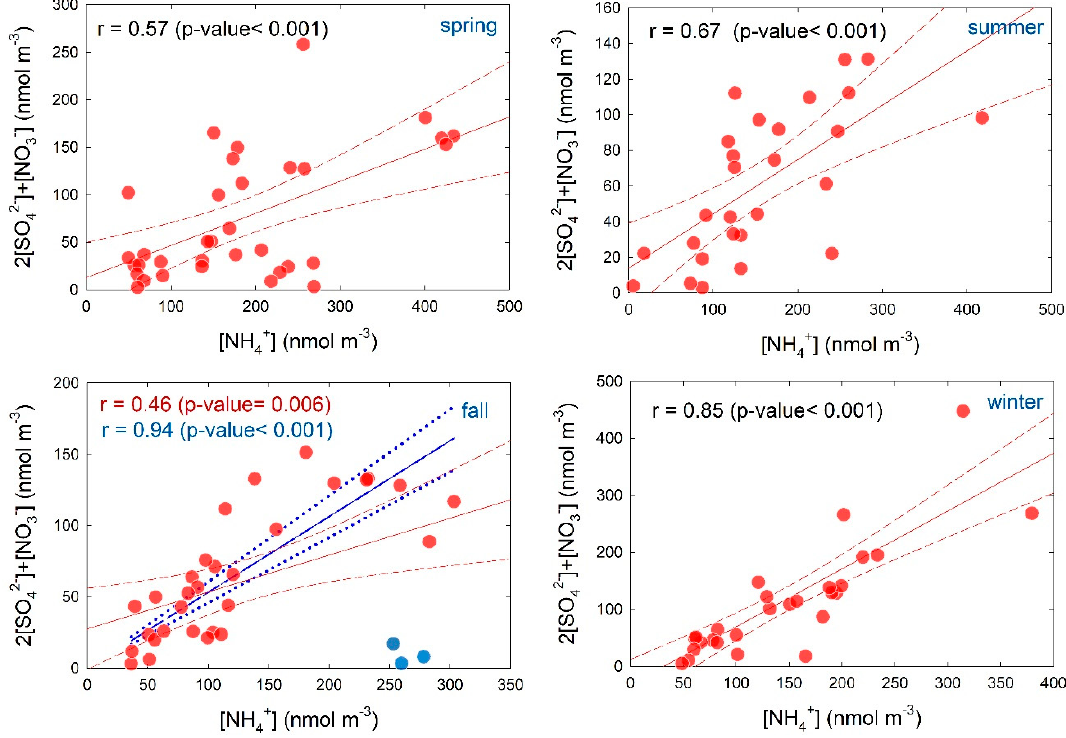
Figure 5. Correlation between the molar concentrations [NH 4 + ] and 2[SO 42 − ] + [NO 3 − ] in each season. The short dash indicates the 95% confidence interval for regression. The blue lines and r value represent the regression results when excluding three blue points for fall.